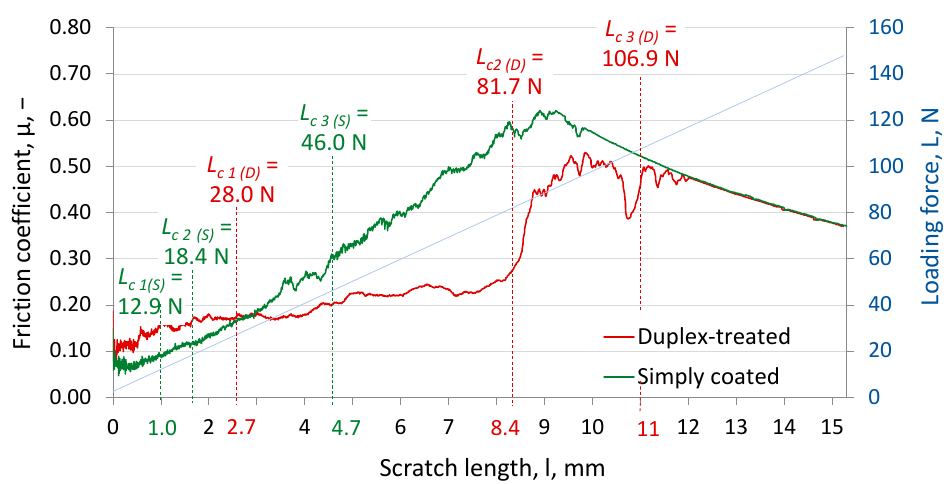
Figure 4. Scratch test diagrams for the simple-coated and duplex-treated samples.